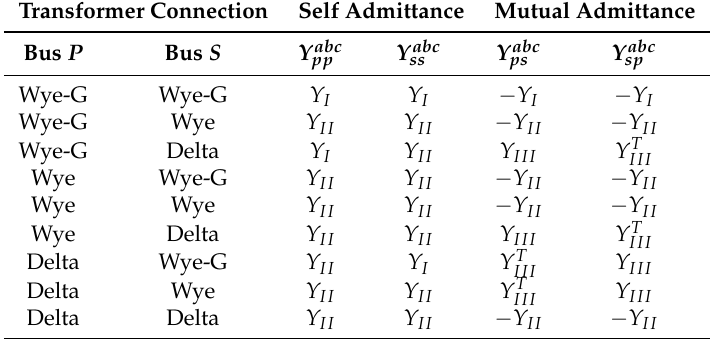
Table 2. Characteristic submatrices of admittance matrices for different transformer